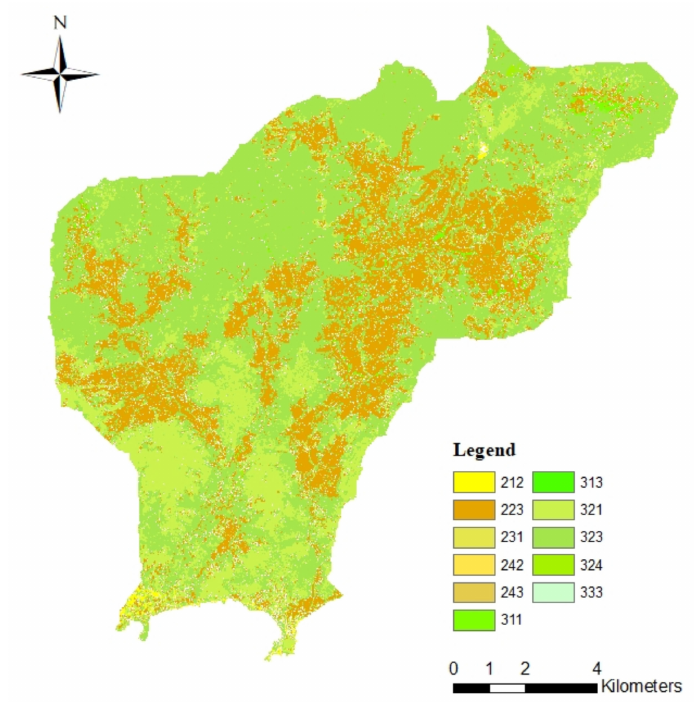
Figure 9. Classified LULC map for Paleochora (2020). After determining the LULC classes from the remotely sensed data, corresponding C-factor values were assigned from literature. The C-factor map derived from the land cover classification (Figure 10) showed that forested areas had the lowest C-factor values, while agriculture areas had higher values.